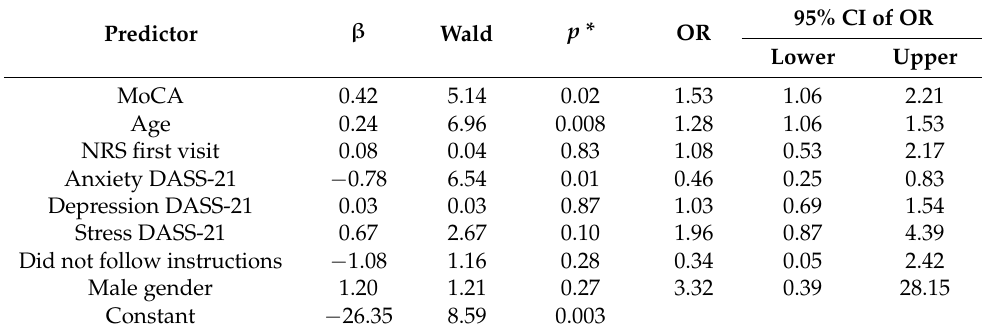
95% CI of OR Lower Upper